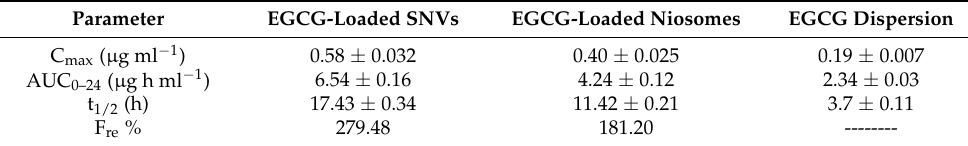
Figure 13. The plasma concentration-time curve of F4, the conventional niosomes, and EGCG dispersion. Abbreviation: EGCG, epigallocatechin gallate. Table 9. Pharmacokinetic parameters of EGCG-loaded